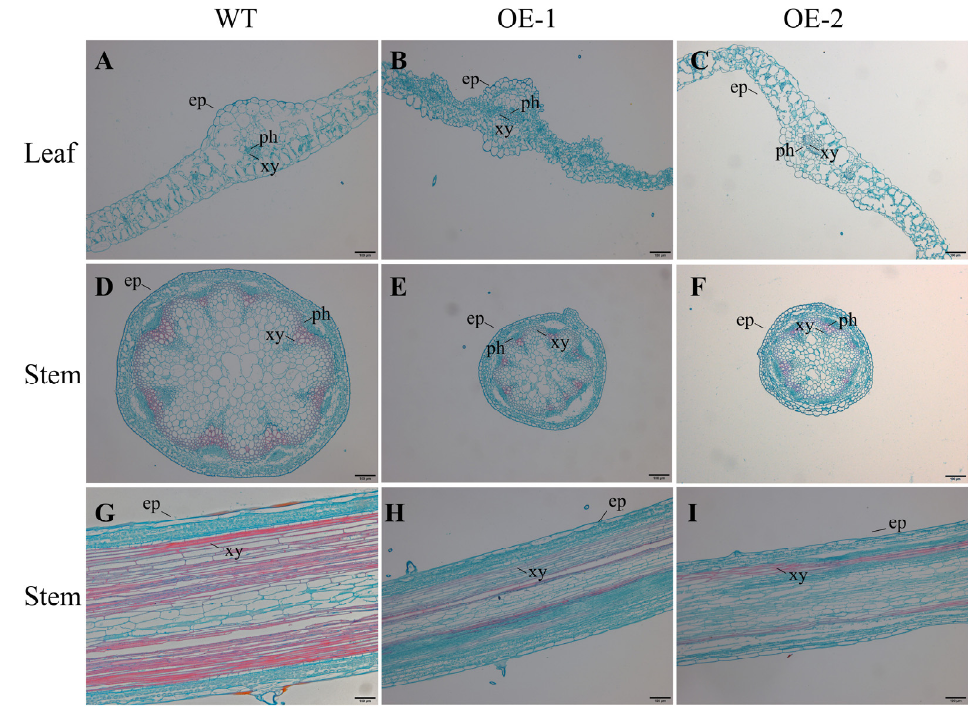
Figure 12. Histochemical staining sections of leaves and stems from WT and transgenic Arabidopsis plants hosting CsLBD39 gene under KNO 3 treat condition. ( A – C ) Histochemical staining of leaves from WT and transgenic Arabidopsis plants hosting CsLBD39 gene. ( D – F ) Histochemical staining of stem cross sections from WT and transgenic Arabidopsis plants hosting CsLBD39 gene. ( G – I ) Histochemical staining of stem longitudinal sections from WT and transgenic Arabidopsis plants hosting CsLBD39 gene. ep, epidermis; ph, phloem; xy, xylem. Scale bar = 100 µ